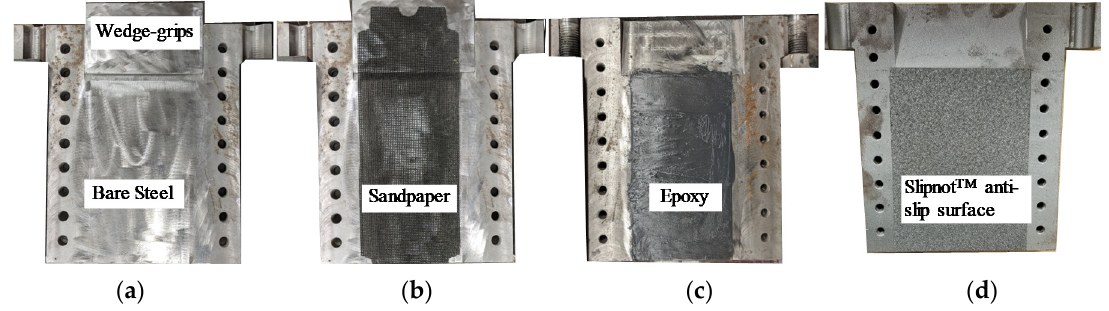
Figure 18. Four bonding mechanisms for clamping the CFRP consisting of ( a ) wedge grips, ( b ) sand- paper, ( c ) epoxy, and ( d ) a Slipnot™ surface.